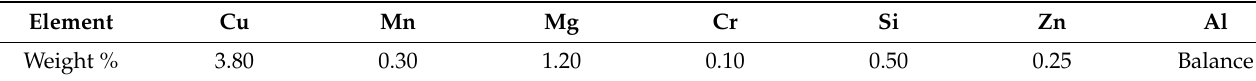
Table 1. The chemical composition of 2024 aluminum alloy.